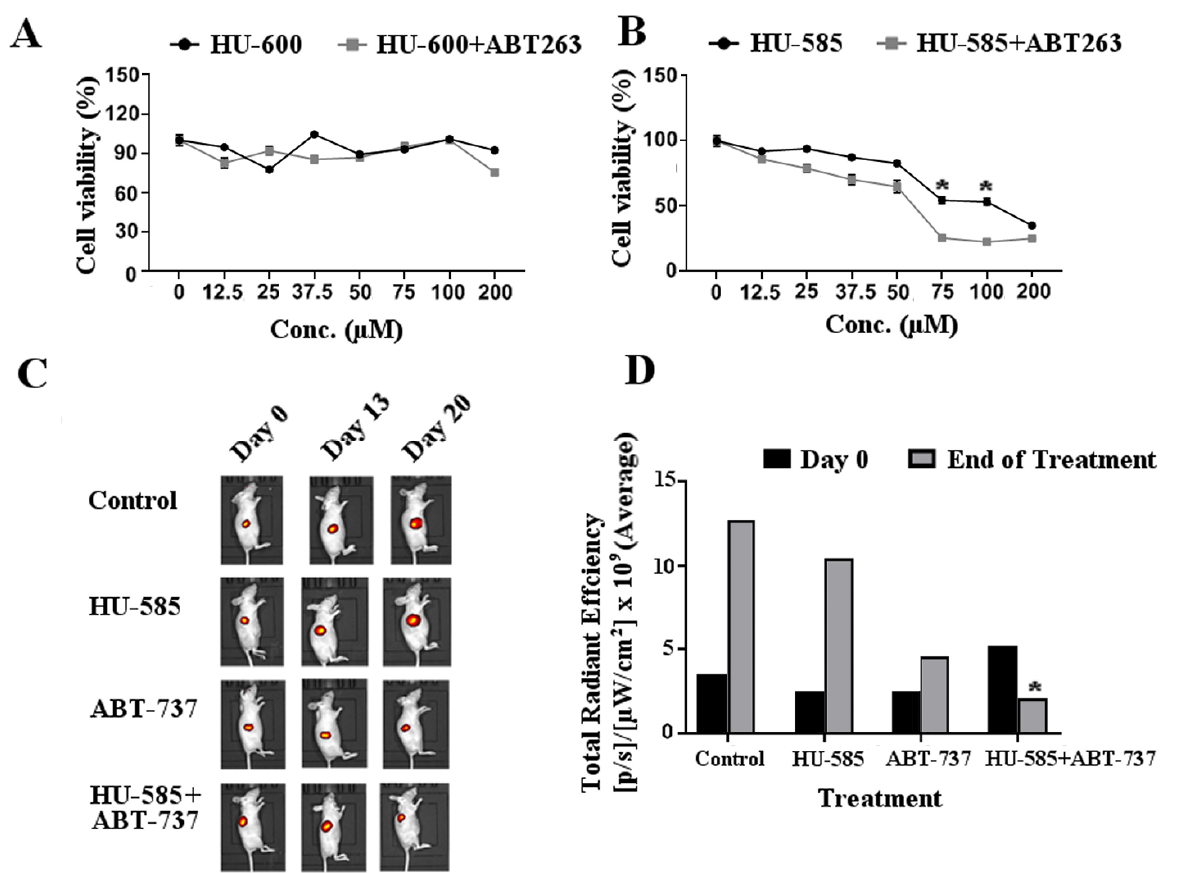
Figure 4. The combination of HU-585 with anti Bcl-2 compounds results in enhanced tumor growth delay in vitro and in vivo. ( A , B ) The effect of combination therapy of ABT-263 with HU-600 or HU-585 on SK-N-SH cells viability. The cells were plated in 96-well plate and treated with increasing concentrations of HU-600 ( A ) or HU-585 ( B ) for 72 h, with or without 2.5 µM of ABT-263. Viability measurements are shown by MTT assay and demonstrate a better effect of ABT-263 treatment combined with HU-585 in comparison to HU-585 alone. A similar effect was not obtained following combination of ABT-263 with HU-600. All values are normalized to control. Data are expressed as percentage of the vehicle control and are the mean of pooled results from several experiments performed in triplicate. Statistical significance was determined by GEE test, * p < 0.05 compared to HU-585 + ABT263 (0.86 < SE values < 4.22). ( C , D ) Combined treatment of ABT-737 with HU-585 inhibited tumor growth in mice model. A total of 5 × 10 6 SK-N-SH expressing mCherry cells were subcutaneously inoculated in the right flank of nude mice. The mice were divided into four groups and given vehicle, HU-585 (120 mg/kg), ABT-737 (75 mg/kg) or combination of HU-585 with ABT-737 (120 mg/kg, 75 mg/kg, respectively) once daily by IP injections for 21 days. ( C ) Tumor burden was followed by IVIS system once a week during treatment. ( D ) Average total radiant efficiency signal was significantly lower following combined treatment with HU-585 and ABT-737 compared to control or HU585 alone. The Kruskal-Wallis test and the post hoc Dunn’s multiple comparisons test were used to evaluate significant differences in the growth rate of xenografts between treatment groups, * p < 0.05 compared to control and HU-585.